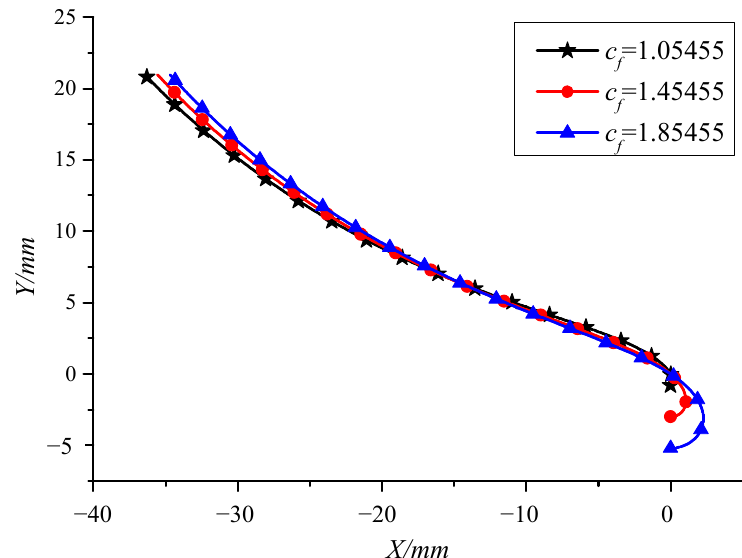
Figure 16. The influence law of c f on the line of action. The influence law of the addendum coefficient of rack c h on the line of action is shown in Figure 17. It can be seen that the c h only affects the length of the line of action. The three different line types with marks represent different values of c h , and the length of the line of action increases with the increase of c h .